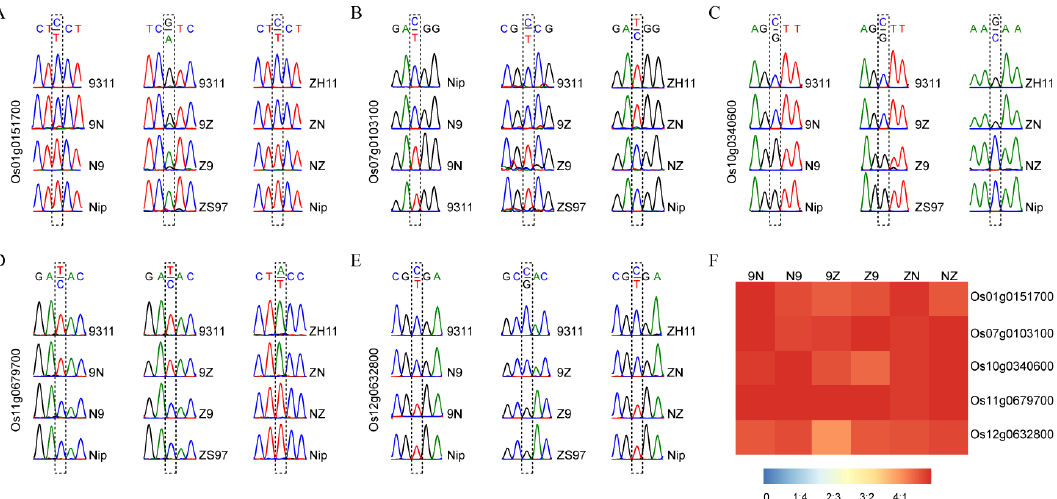
Figure 1. Validation of five conversed imprinted genes in endosperm. ( A – E ) The RT-PCR sequencing results of Os01g0151700 , Os07g0103100 , Os10g0340600 , Os11g0679700 , and Os12g0632800 . ( F ) The ratio of maternal expression to paternal expression for each gene.